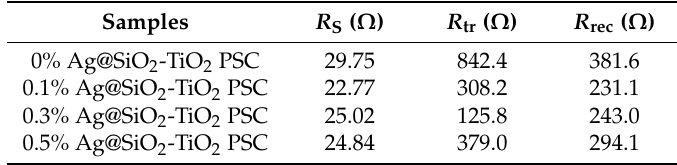
Figure 10. ( a ) Nyquist curves of the PSC devices based on different amounts of Ag@SiO 2 NPs films and ( b ) the equivalent circuit employed to fit the plots. Table 3. Summary of EIS parameters of PSCs based on different amounts of Ag@SiO 2 NPs films.